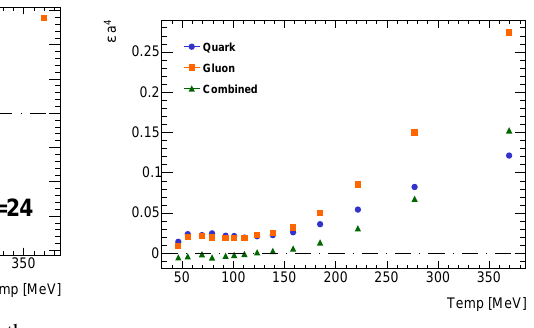
(a) Quark number density normalised by the non- interacting number density. Figure 3: Quark number density. These result are compatible with previous results on a smaller volume in [2].